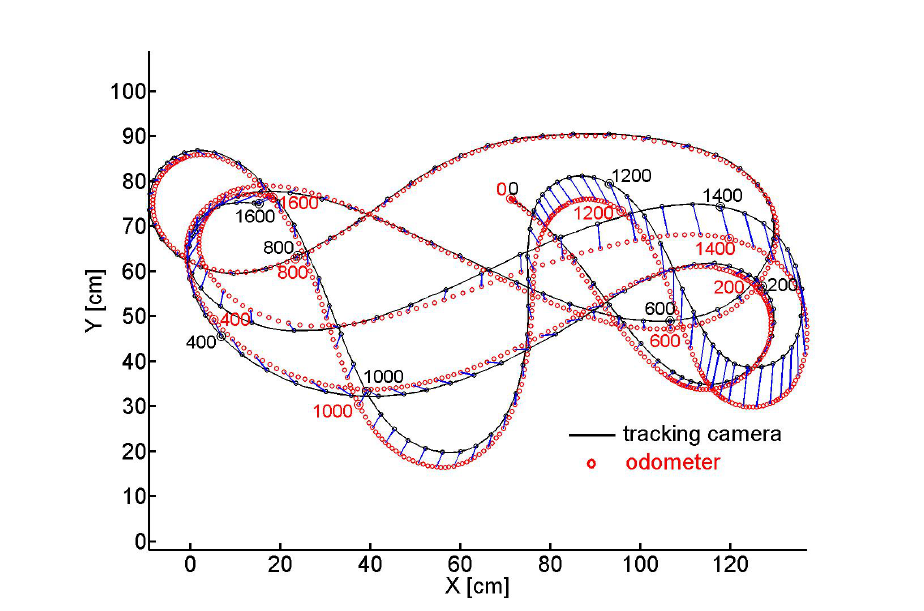
Figure 9. ( X, Y ) coordinates of the 10m curved track of the odometer dragged by hand. The data are presented in a similar way as in Figure 7.